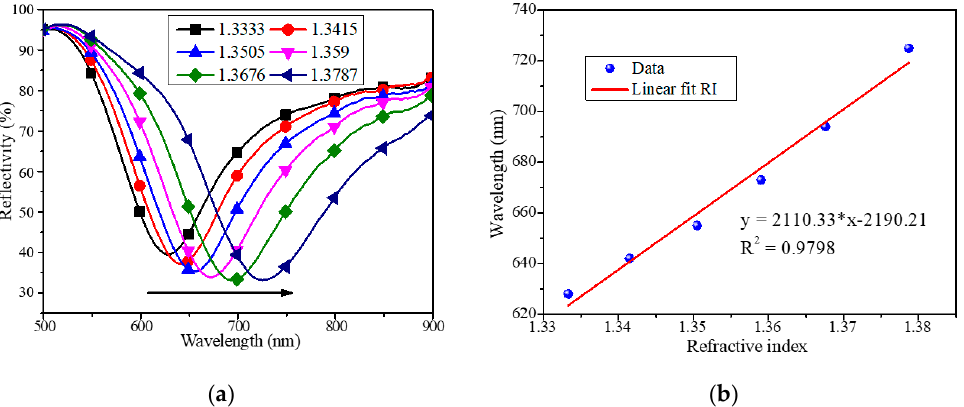
Figure 7. Resonant spectra ( a ) and linear fitting result ( b ) of a reflective fiber SPR sensor in refractive index measurement.